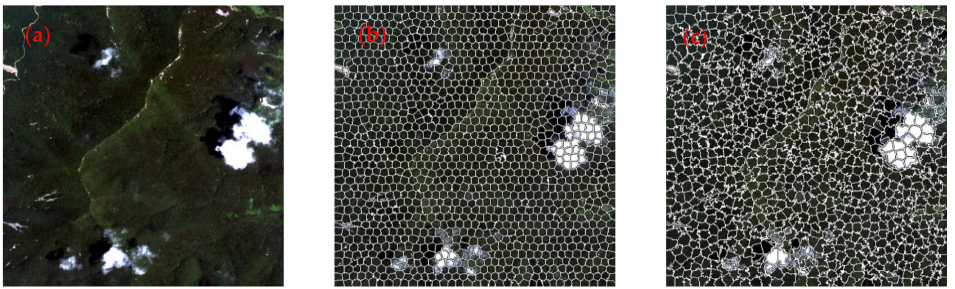
Figure 3. Segmentation results. ( a ) Original image; ( b ) A-SLIC segmentation results; ( c ) SLIC segmentation